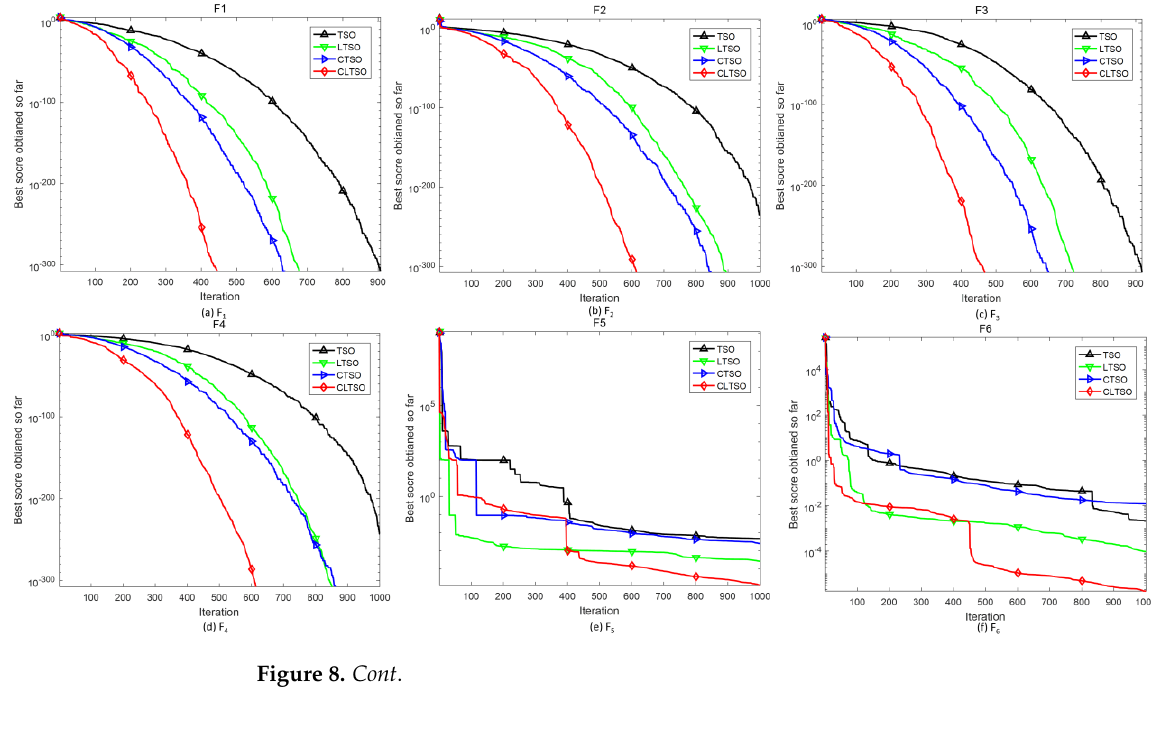
Figure 8. C ont . Figure 8. Cont